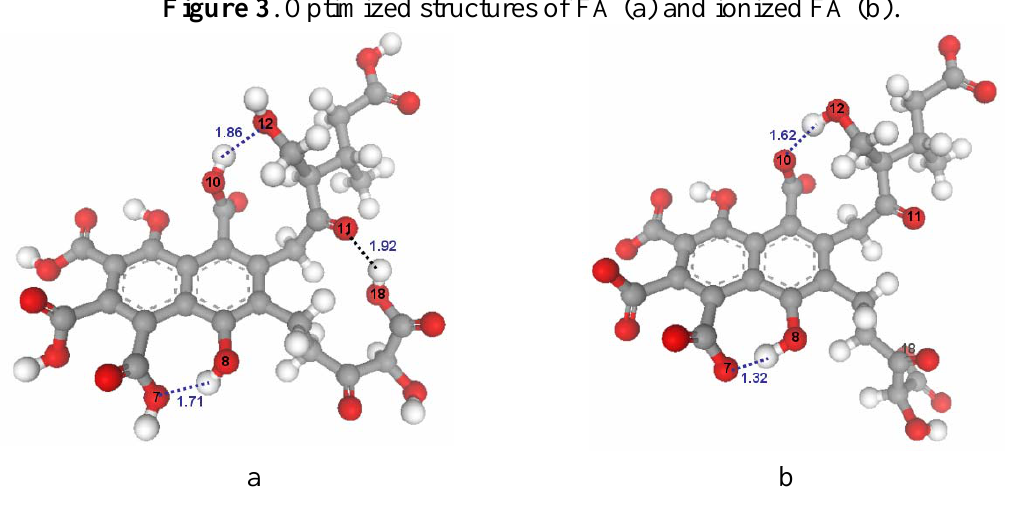
Figure 3 . Optimized structures of FA (a) and ionized FA (b).